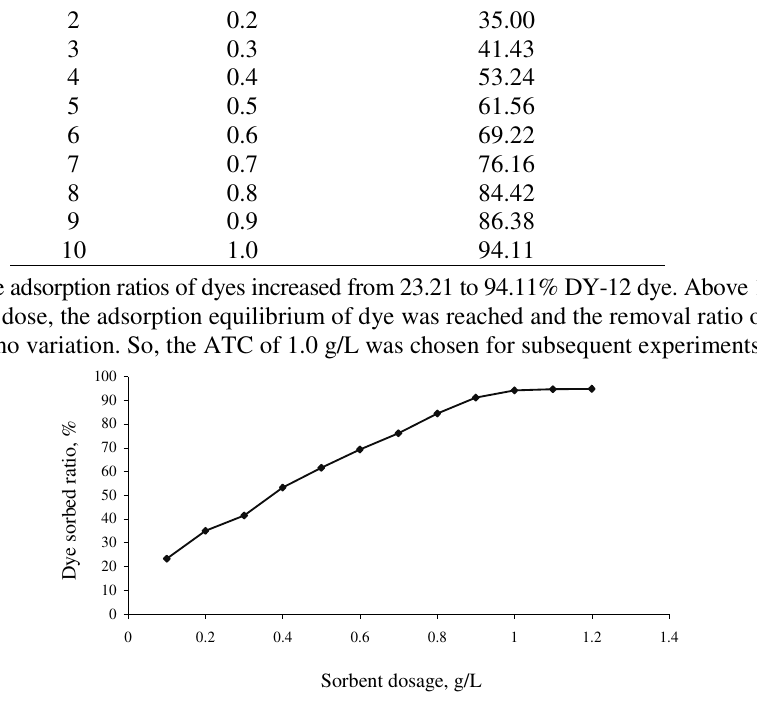
Figure 1. Effect of sorbent dose on adsorption of